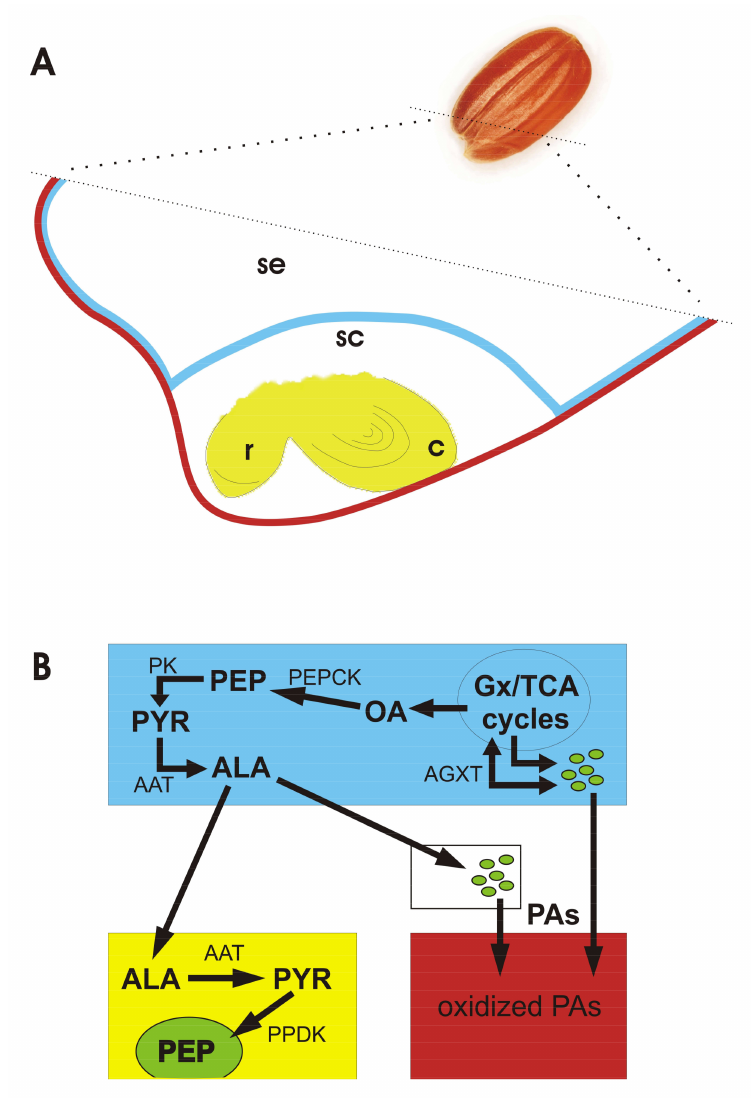
Figure 3. Proposed nutritional relationships in the D seed. ( A ) Representation of a section of the proximal region of the caryopsis. The caryopsis coat is red; the source tissues (scutellar epithelium and aleurone layer), which actively provide nourishment to the embryo by degrading reserves stored in the starchy endosperm (se) are represented by a light blue color (but they are colorless, in actuality); the embryo axis (i.e., the primordia of the radicle, r, and of the plumule, which is enveloped by the coleoptile, c) is highlighted in yellow (but it is colorless, in actuality). The embryo axis is embedded in the embryo collar, i.e., the grass hypocotyl that is expanded to form a bulging tissue and is fused with the scutellum (sc). ( B ) Schematic representation of the proposed nutritional relationships within the imbibed D caryopsis: rectangles correspond to compartments as colored in ( A ). The white rectangle represents the collar epithelium. Green ellipses represent proplastids (which are colorless, in actuality). In the source tissues, both storage reserves from the starchy endosperm and endogenous ones (soluble sugars/amino acids, oleosomes and protein bodies) can be utilized. Carbon skeletons undergo gluconeogenesis through the glyoxylate/TCA (Gx/TCA) cycles only in the source tissues. They are then transferred to the local proplastids for production of proanthocyanidins (PAs) and, through alanine (ALA), to the embryo axis, wherein they are, again, mainly used for biosynthetic processes in the proplastid. Supposedly, transferred reserves are used for PA synthesis in the collar epithelium too. Once released exogenously, PAs oxidize to the reddish pigments characterizing the caryopsis of red rice. AGXT, alanine:glyoxylate aminotransferase; OA, oxaloacetate; PEP, phosphoenolpyruvate; PYR, pyruvate; PK, pyruvate kinase; AAT, alanine aminotransferase; PEPCK, phosphoenolpyruvate carboxykinase; PPDK, pyruvate phosphate